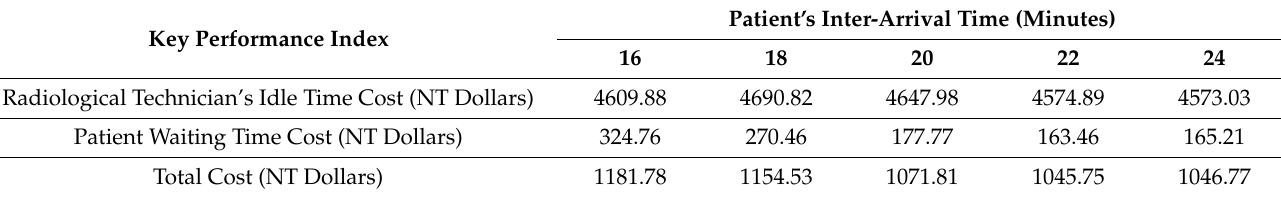
Table 16. Sensitivity analysis 3 with the pair cost coefficients (0.2,